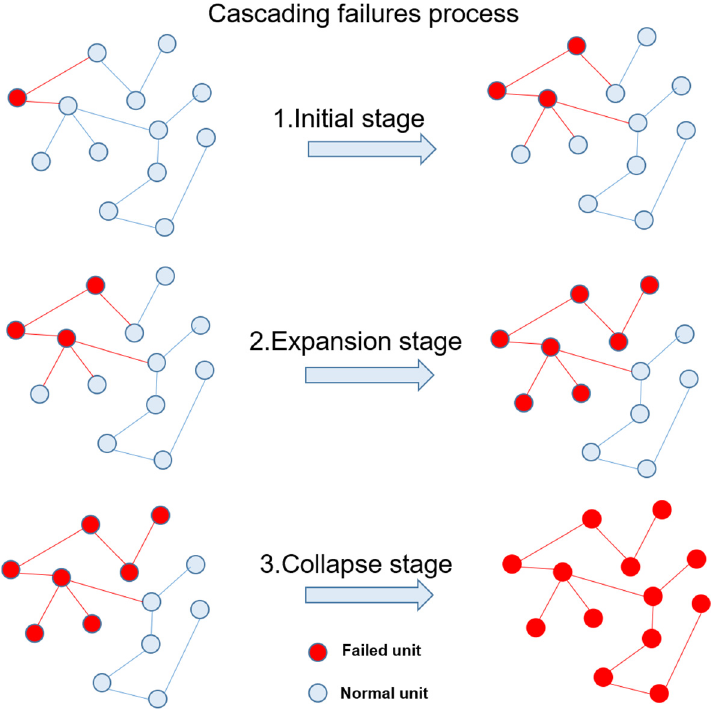
Figure 8. Cascading failure process.